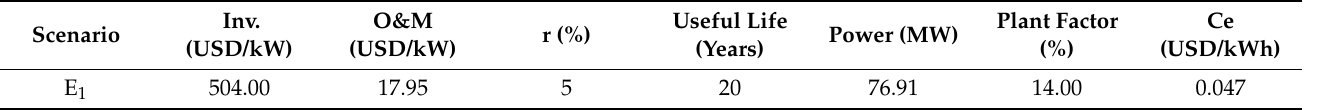
Table 18. Energy costs (DHW